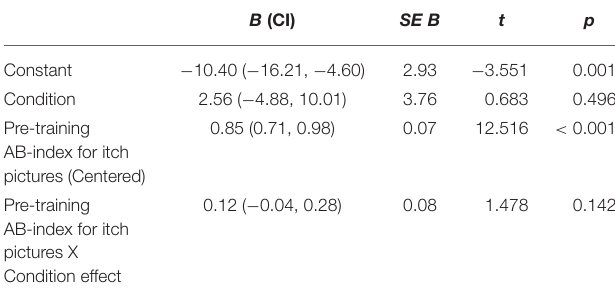
Table 6 | Linear model of pre-training attention bias (AB)-index for itch pictures as predictor (moderator) of the attention bias modification (ABM) training effect [ n